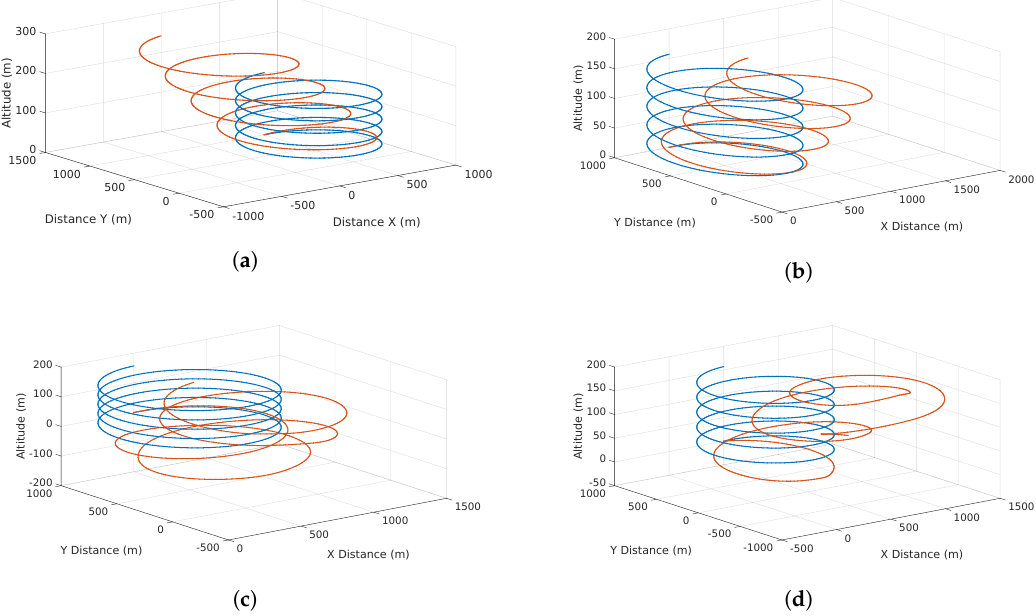
Figure 9. Effects of different simulated features on the vehicle trajectory: ( a ) the effect of a shear wind with increasing deviation as altitude rises; ( b ) the effects of a discrete gust with a constant deviation on the trajectory in a single direction; ( c ) a chaotic deviation due to the effects of a continuous gust; and finally ( d ) the total effects of the wind present at the same